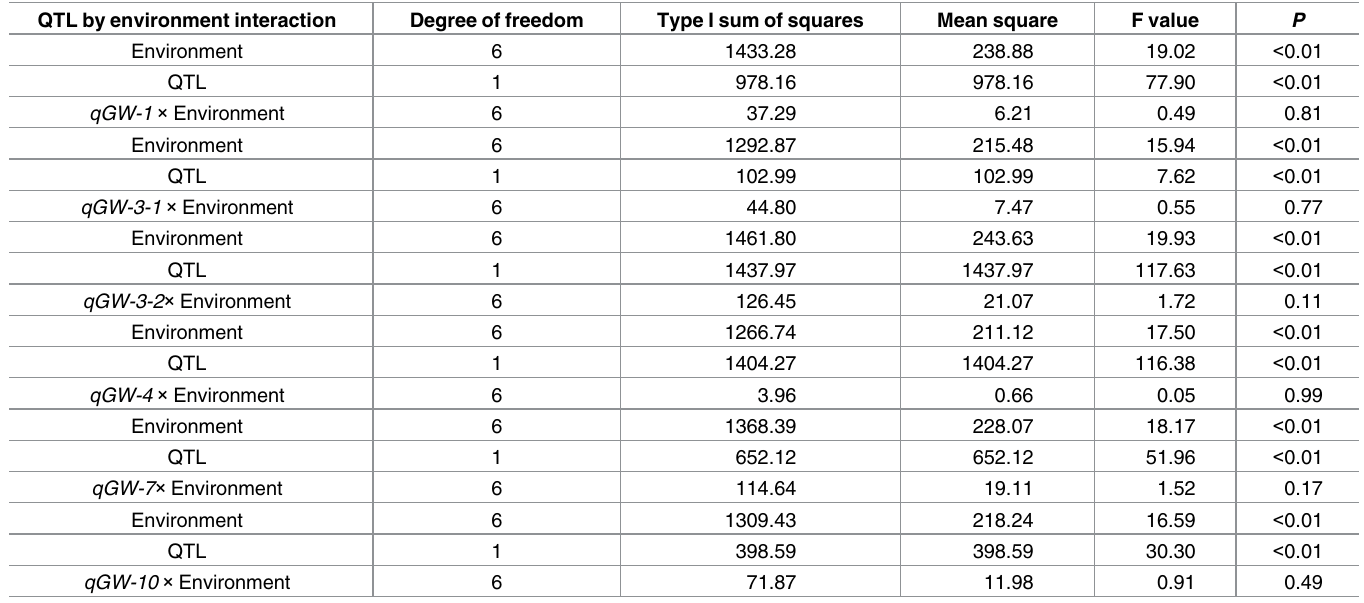
Table 2. Quantitative trait loci (QTLs)-by-environment interactions examined using two-way analysis of variance. As seven mappingenvironments were considered (three primary and four recombinant inbred line mappingpopulations), there were six degreesof freedom. Becausethere were two geno- types at each QTL (heterozygotes were omitted and not used in the analysis),the degreeof freedom for QTL was 1. QTL by environment